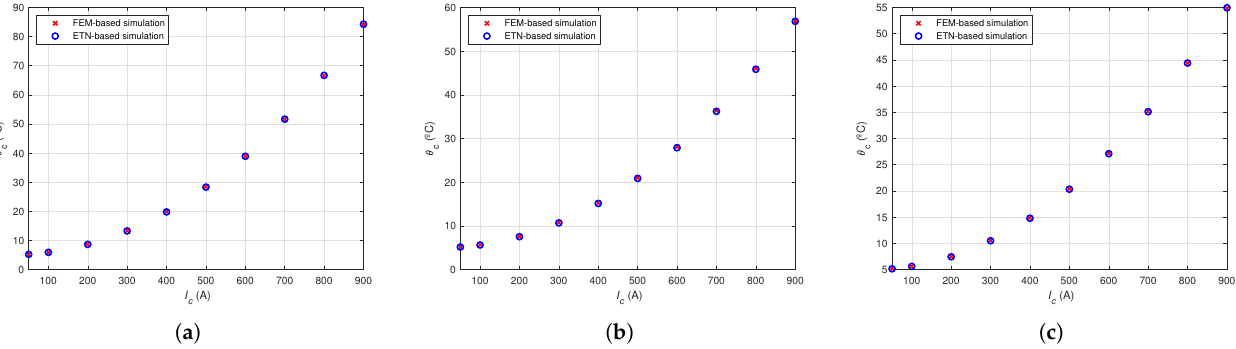
Figure 20. Estimation results with θ amb = 5 ◦ C, d p = 1 m and k soil = 1 W/(K · m) for: ( a ) Cable 1E; ( b ) Cable 2R; ( c ) Cable